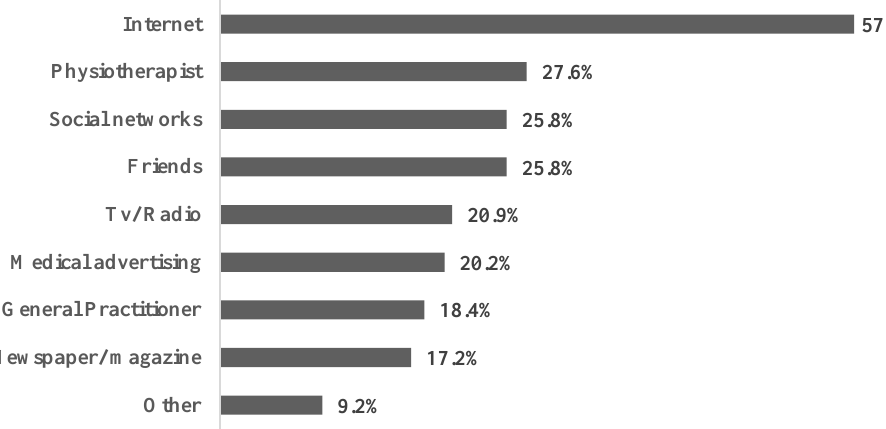
Figure 2. Distribution of the answers to the question “Where did you get information about exercise for pregnancy”. Table 2. Distribution of the answers to the question "Where did you find out about exercise for pregnancy?" depending on respondents’ status.